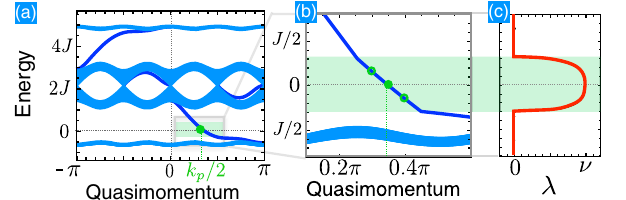
FIG. 2. Topological band structure. (a) Band structure of a semi-infinite strip for the Hofstadter model with a flux of π = 2 (when the parametric driving is switched off). The edge states are plotted in dark blue. The energy is counted off from half of the pump photon energy. The solid green circle indicates the tuning of the pump photon quasimomentum k required to resonantly FIG. 3. Linear response of the topological amplifier. (a),(b) The p excite pairs of down-converted edge state photons with quasi- topological amplifier is formed by a 30 × 12 array of photonic = 2 (at the quasimomentum k = 2 the edge state momentum k nanocavities. Three of the cavities at the edge of the sample are p p should have energy E ¼ 0 ). (b) Zoom of the band structure for a attached to waveguides, the input and output ports of the finite laser power. In the unstable energy interval highlighted in amplifier, and an additional sink port. (c) The amplifier has green, pairs of Bogoliubov excitations having quasimomenta the geometry of a circulator. (a),(b) The red ellipses represent the k = 2 (cid:2) δ k are also excited. The corresponding amplification linear response of the field inside the photonic array as a function p of the incoming signal phase. The signal is injected at the port amplitude λ is shown in (c). Parameters are ω 0 ¼ 2 . 15 J , Φ ¼ π = 2 , k 2 . 2 . In (b) and (c), ν ¼ 0 . 08 J . marked by an inward arrow. (a) A signal injected at the input port p ¼ propagates unidirectionally toward the output port. The response is strongly phase sensitive; a signal with the right phase is amplified along the way. (d) Transmission power gain for the amplified quadrature as a function of the frequency of the input signal (counted off from half of the pump frequency) for a disordered (light thick line) and a clean sample (dark thin line). The reflection coefficient at the input is shown in (e) for the disordered sample. (b) A signal propagating from the output port toward the input port follows a different path and it is not amplified. Moreover, an appropriate matching of the impedances ensures that it leaks out at the sink port. The resulting (small) reverse transmission from the output to the input of the amplifier is the blue curve in (e). Parameters are ω 0 ¼ 2 . 14 J , Φ ¼ π = 2 , ν ¼ 0 . 08 J , 4 . 2 J . In the disordered simulations, the offset energies sink ¼ δω j , represented by the gray scale in (a) and (b), are random numbers in the interval − 0 . 1 J < δω j < 0 . 1 J